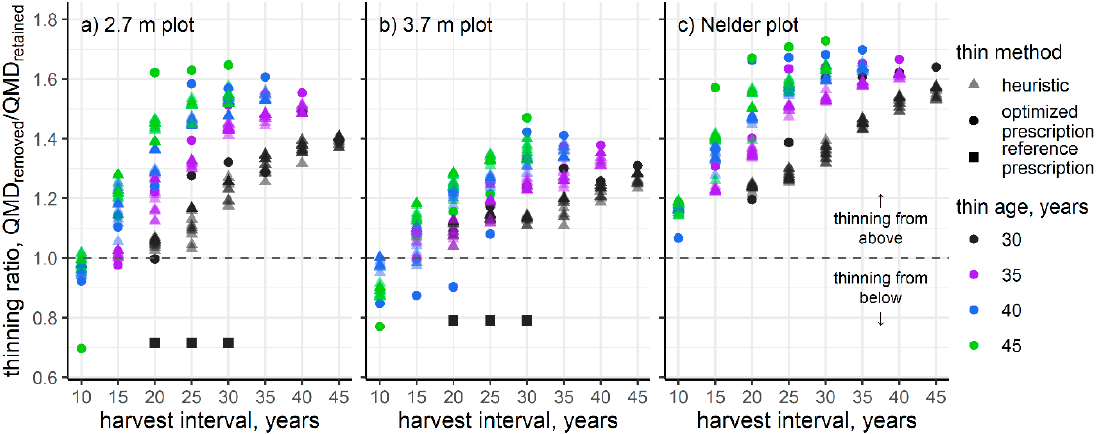
Figure 7. Thinning ratios obtained on each plot as a function of thinning method, a plot’s stand age at time of thinning, and the length of the even age rotation (the harvest interval was the number of years between thinning and end of rotation). Thinning ratios greater than 1.0 (dashed line) indicate thinning from above, and ratios below 1.0 indicate thinning from below.